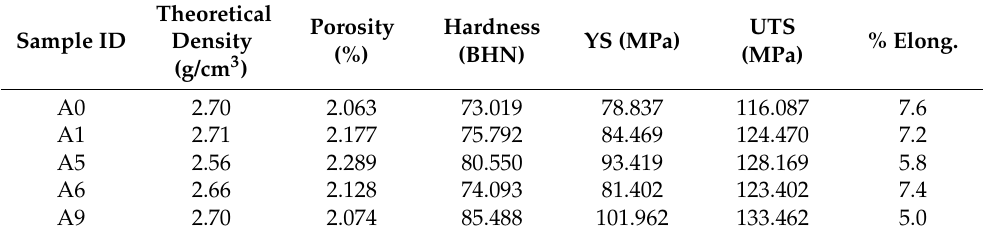
Table 2. Physical and mechanical properties of the fabricated